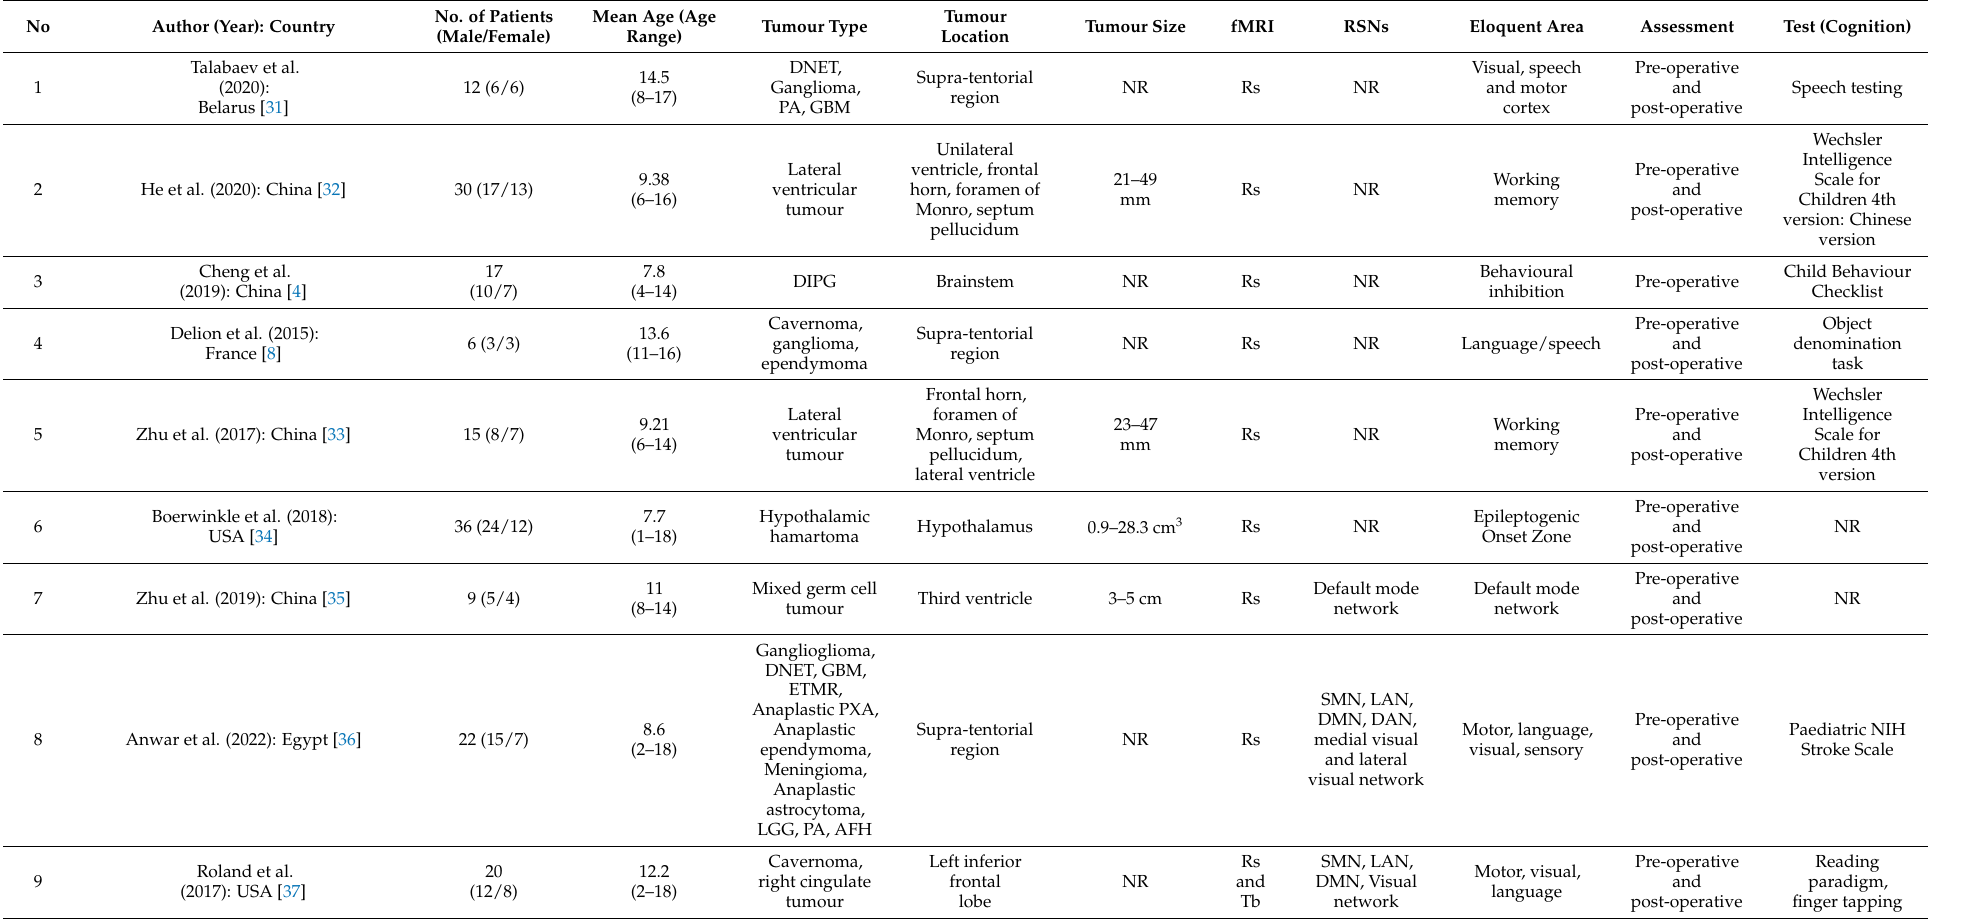
Table 2. Demographic data of patients, tumour characteristics and eloquent areas (resting-state